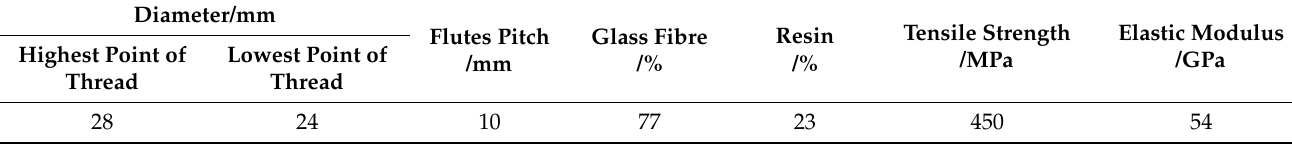
Table 5. Testing bar arrangement. Table 4. Mechanical properties of the GFRP bar.